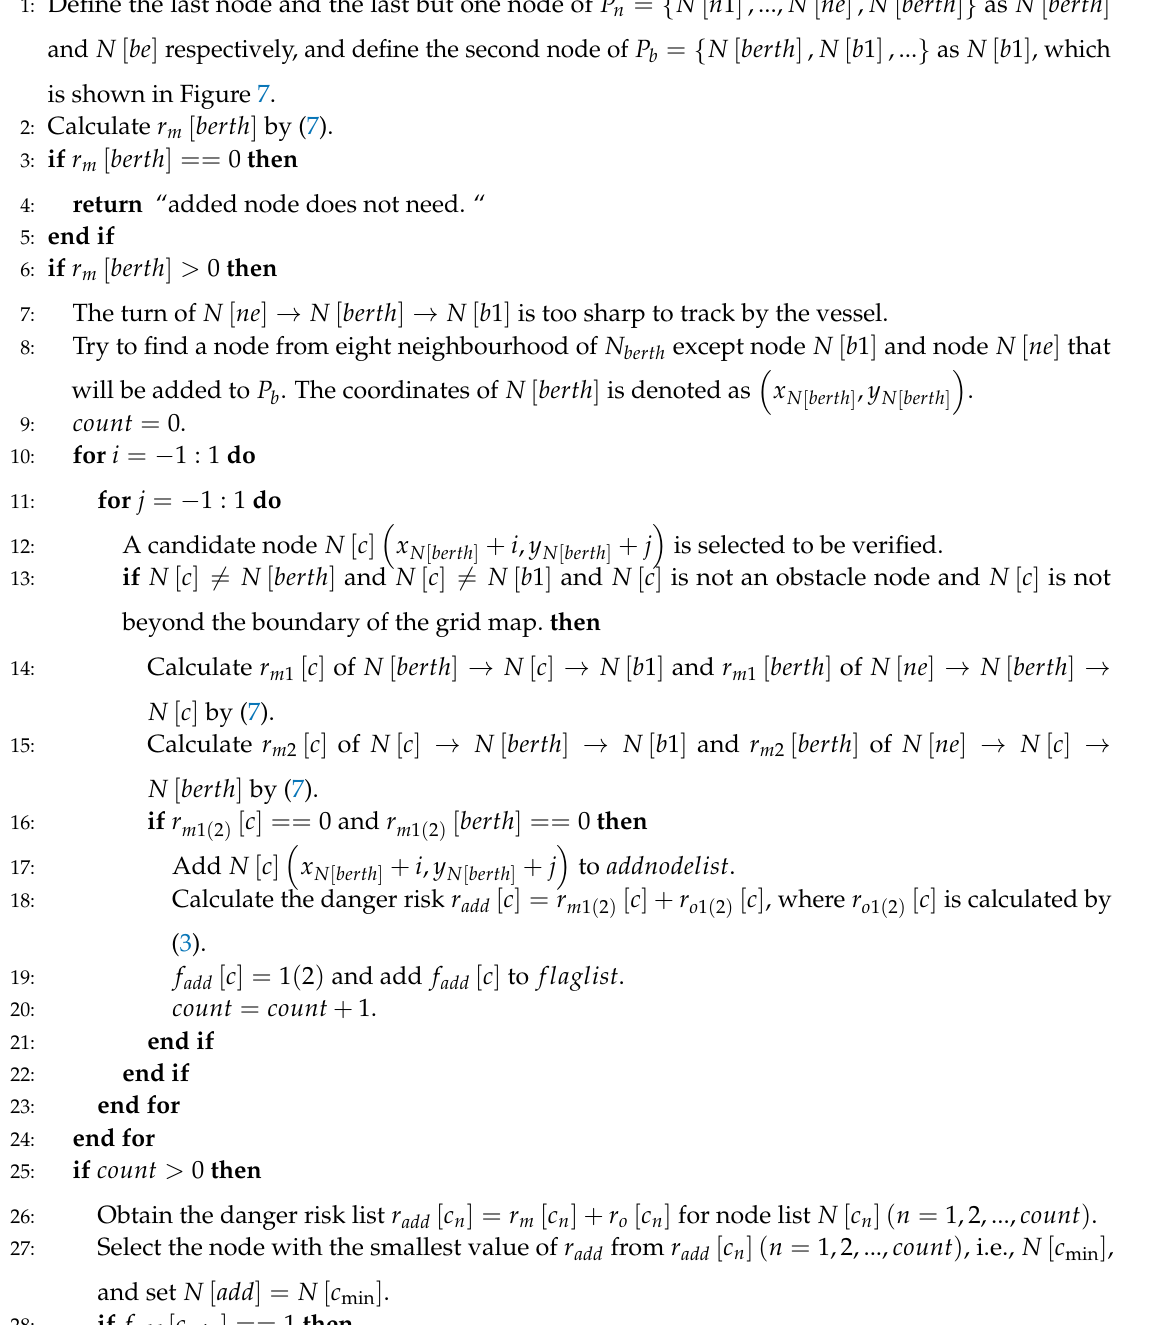
Algorithm 4 Smoothing the combined path algorithm ( P c = P n + P b